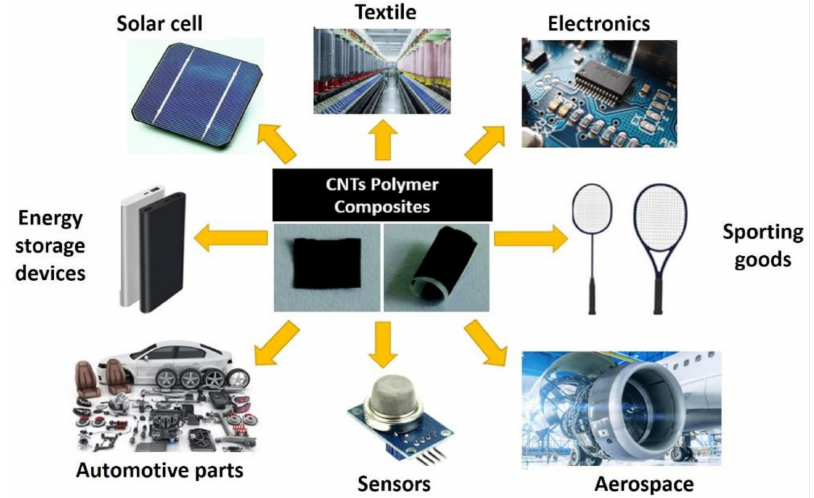
Figure 11. Application of CNT–polymer